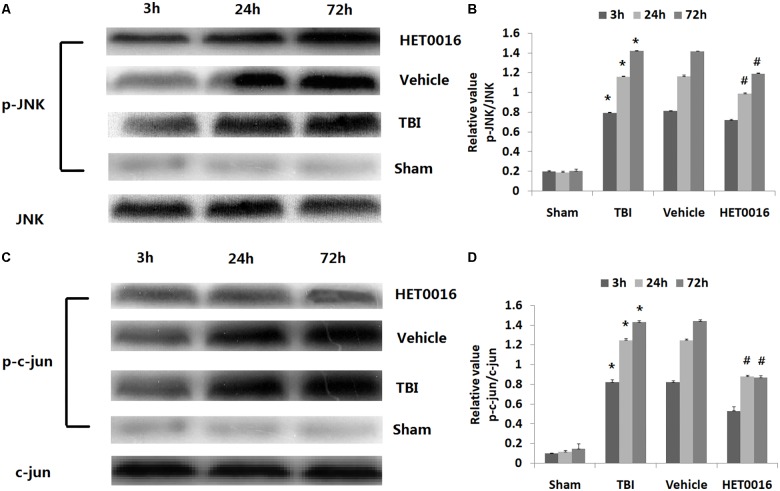
The effect of HET0016 on c-Jun N-terminal protein kinase (JNK) and c-jun activation at 3, 24, and 72 h after injury. (A,B) Representative photos and the quantitative analysis of the ratio of JNK. (C,D) Representative photos and the quantitative analysis of the ratio of c-jun. ∗P < 0.05 compared with the corresponding sham group at the same time point; #P < 0.05 compared with the vehicle-treated group.